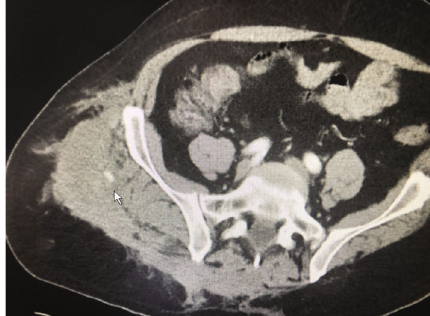
Figure 2: Digital subtraction angiography screenshot for the fi rst patient; there is a visible pseudoaneurysm.